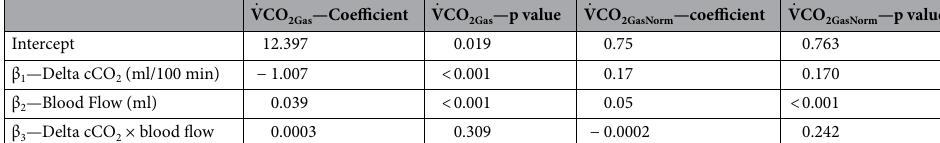
. V CO 2 = 0.743, 2Gas (r